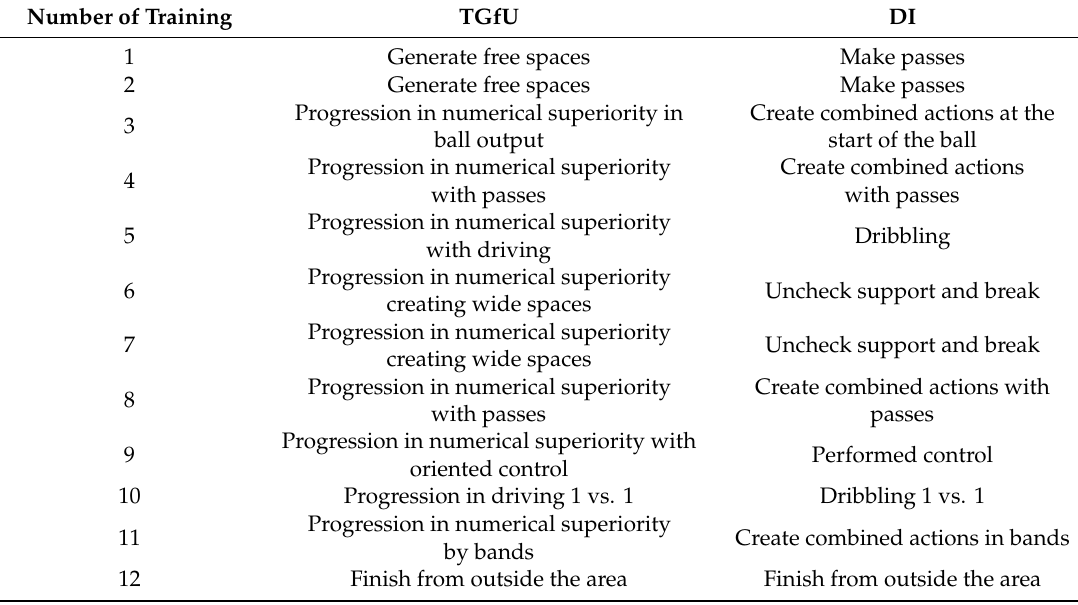
Table 2. Training aims by training session and pedagogical